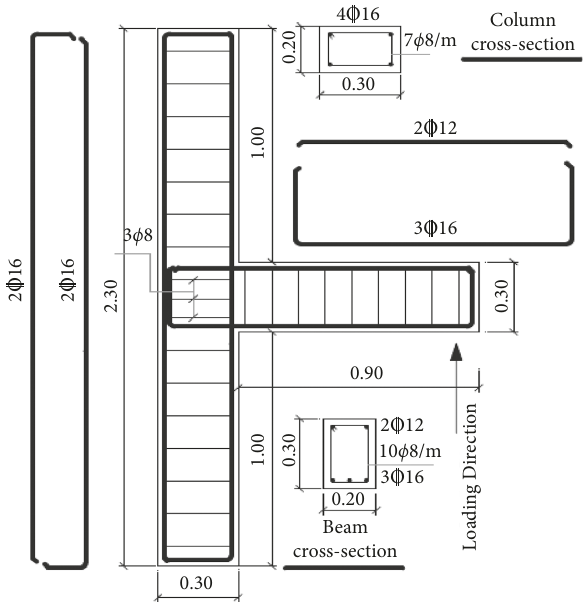
Figure 1: Model geometry and reinforcement detailing [25].